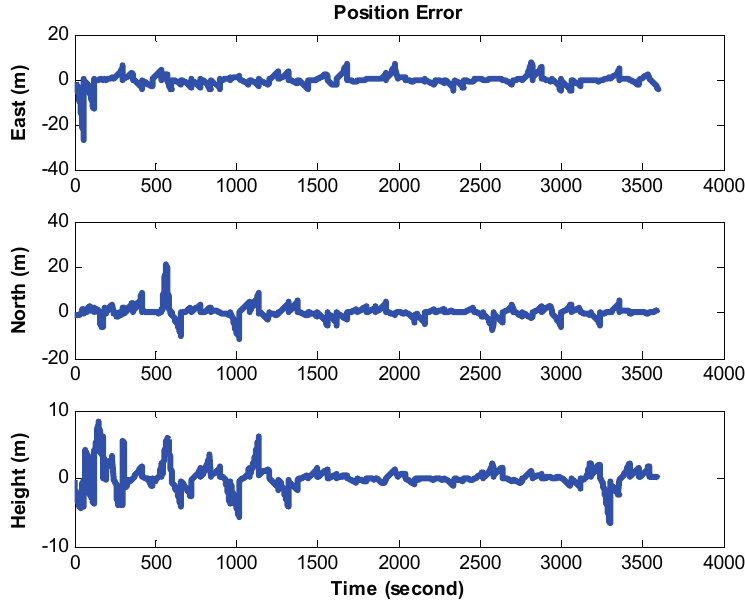
Figure 9. The error comparison for position in land